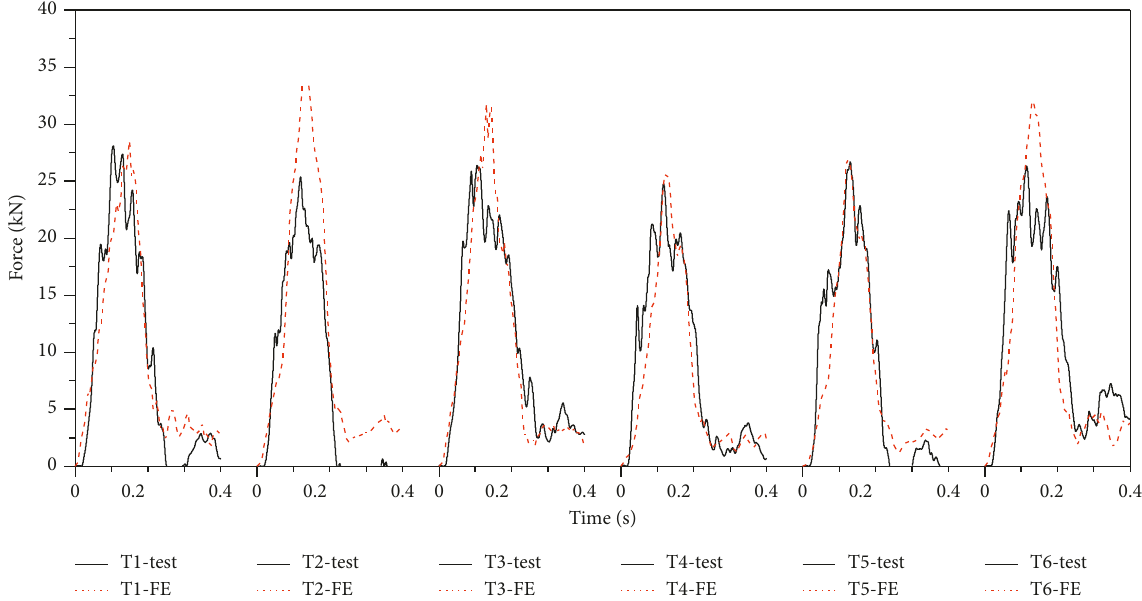
Figure 16: Time-history curves of the internal tensile force of the support ropes (see Figure 10(a) for the rope